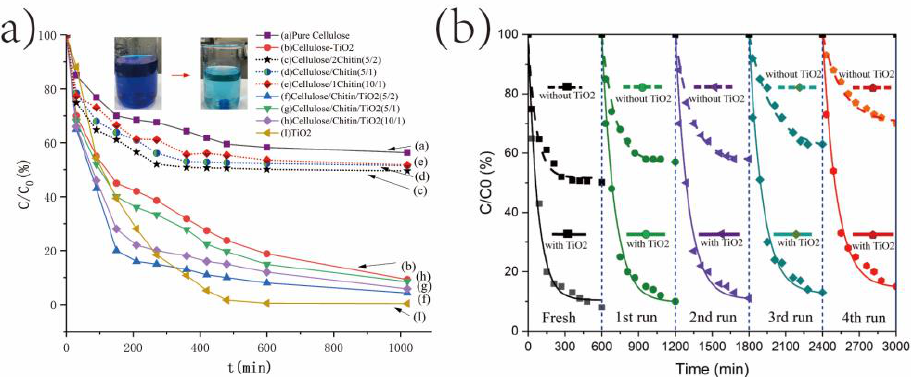
Figure 7. ( a ) Photodegradation curves of MB solution for 3D-printed cellulosic composites and pho- tocatalysts under UV irradiation of pure cellulose, pure TiO 2 , TiO 2 /cellulose, TiO 2 /chitin/cellulose with 0.5 g, 1 g, 2 g of chitin added to 5 g cellulose, and chitin/cellulose with 0.5 g, 1 g, 2 g of chitin added to 5 g cellulose, respectively; ( b ) 5 cycles of photodegradation of MB using the TiO 2 /chitin/cellulose (2 g chitin to 5 g cellulose) sample and the chitin/cellulose (2 g chitin to 5 g cellulose, without TiO 2 )